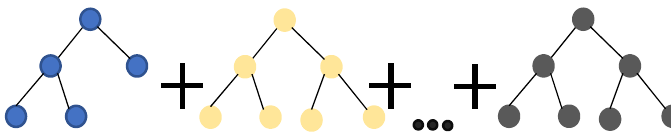
Figure A10. The introduction to Classification and Regression Trees.